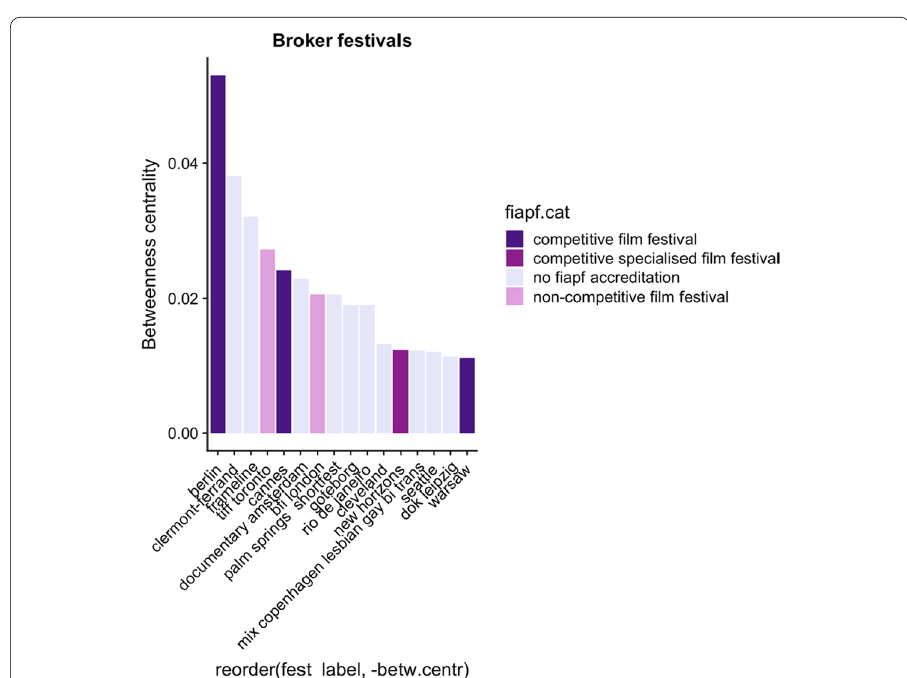
Fig. 14 Broker festivals based on top 99 percentile in distribution of betweenness centrality for second operationalization. Note : Festivals with higher betweenness centrality connect clusters of festivals that would otherwise be disconnected. The figure shows that among these 16 selected festivals, 6 are included in the